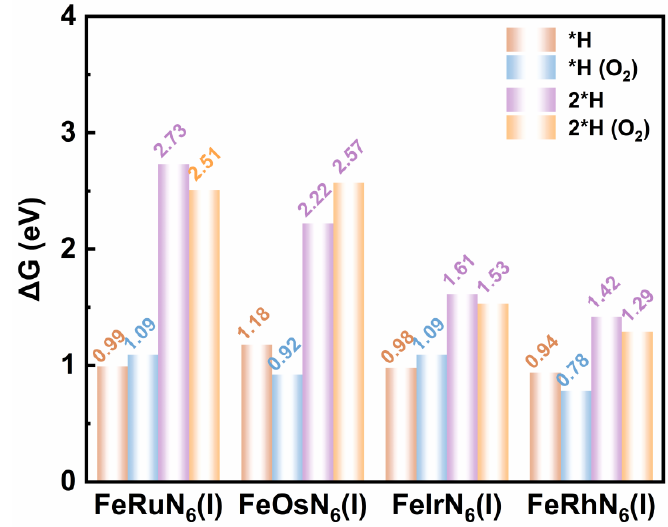
Figure 6. ΔG *H and ΔG 2*H for FeRuN 6 (I), FeOsN 6 (I), FeRhN 6 (I), and FeIrN 6 (I).